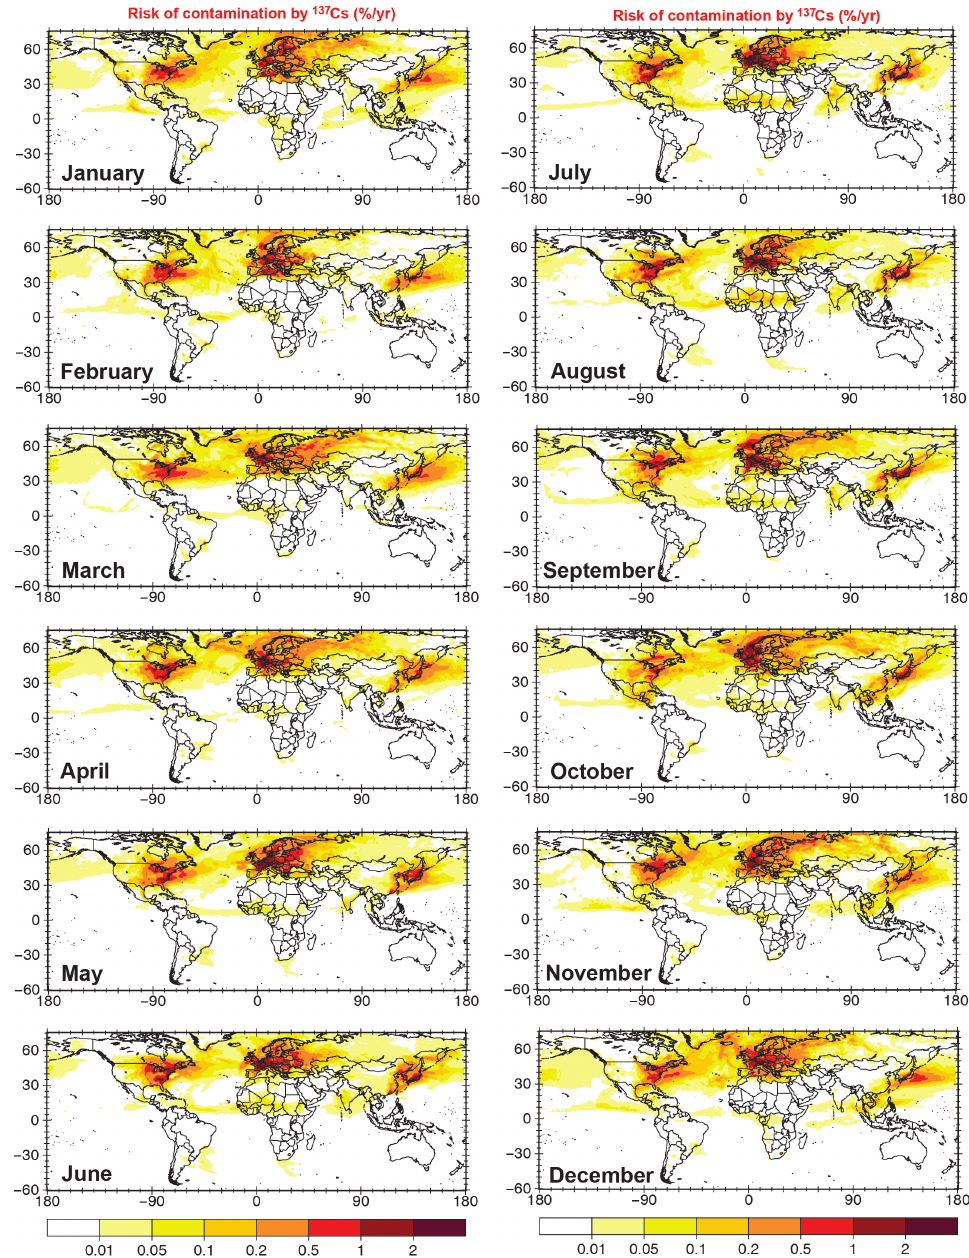
Fig. 6. Global risk of radioactive contamination by 137 Cs based on the modelled deposition of ≥ 40kBq 137 Csm − 2 /month, applying the same emission as in Fig. 2 though monthly instead of